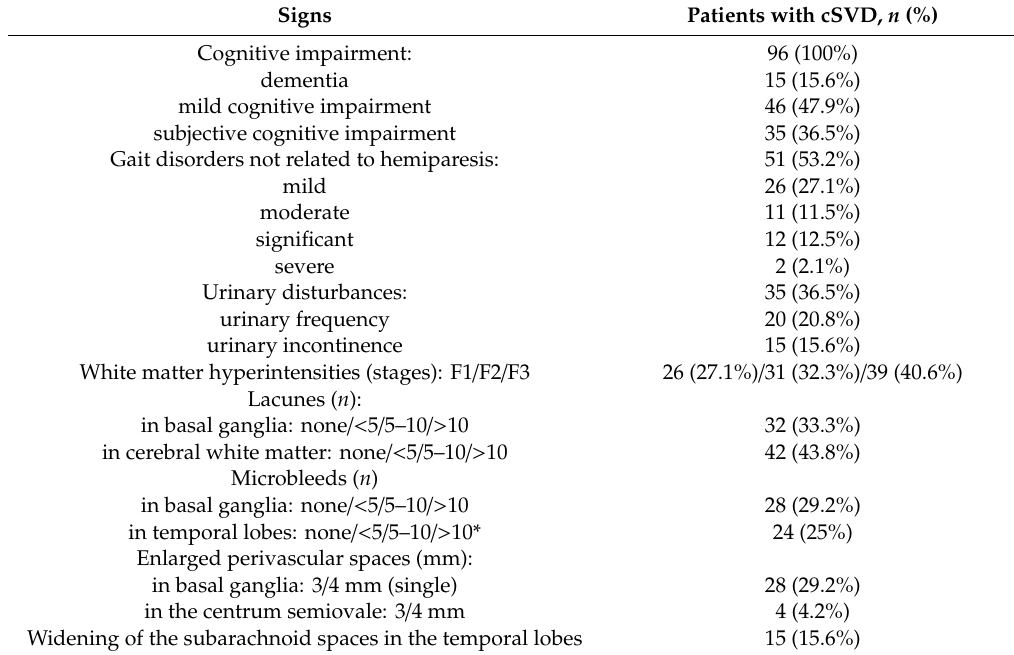
Table 2. Features of the main clinical syndromes and MRI signs in patients with cerebral small vessel disease. Signs Patients with cSVD, n (%)